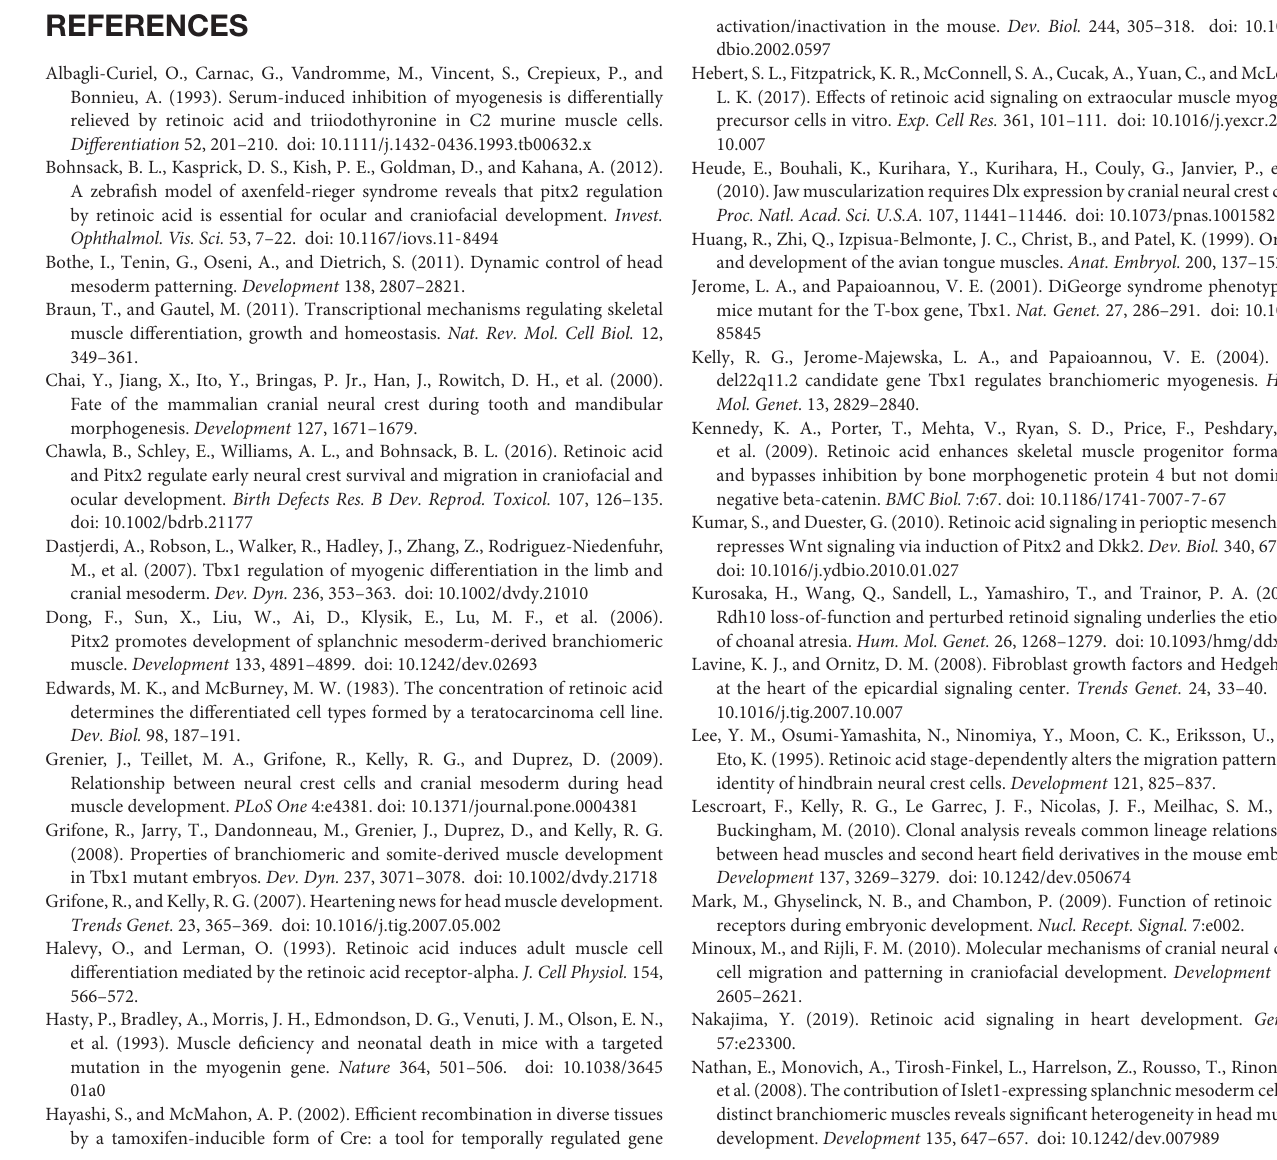
Supplementary Figure 2 | In situ hybridization of Myogenin in E13.0 head. Myogenin in situ hybridization for whole-mount in E13.0 Control (left) and Cre- ERT2:Rdh10 flox / flox (Right) head. au, auricularis muscle; bu, buccinators muscle; ma, masseter muscle; te, temporalis muscle; zy, zygomaticus muscle. Supplementary Figure 3 | In situ hybridization of Aldh1a2 and Aldh1a3 in E10.5 branchial arches. Whole mount in situ hybridization of Aldh1a2 and Aldh1a3 in E10.5 RA-treated and Cre Ert2;Rdh10 flox / flox embryos. The labels on the left indicate the genes whose expression was examined and the labels on the top indicate the condition of the sample treatments. Supplementary Figure 4 | In situ hybridization of Retinoic acid receptors ( Rars and Rxrs ) in E10.5 branchial arches. Whole mount in situ hybridization of Rara , Rarb , Rarg , Rxra, Rxrb, and Rxrg in RA-treated and CreErt2;Rdh10 flox / flox embryos. Labels on the left indicate the genes whose expression was examined and labels on the top indicate the condition of the sample treatments. Asterisks indicate the position where different expression profiles could be detected among comparable